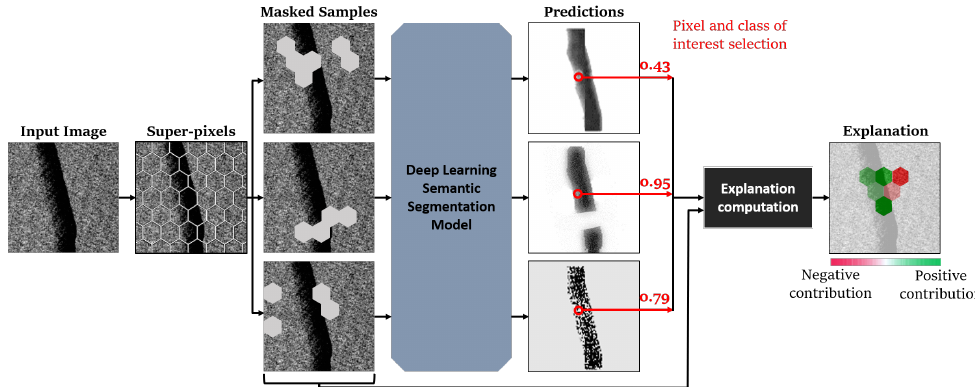
Figure 11. Overview of SHAP adaptation to image semantic